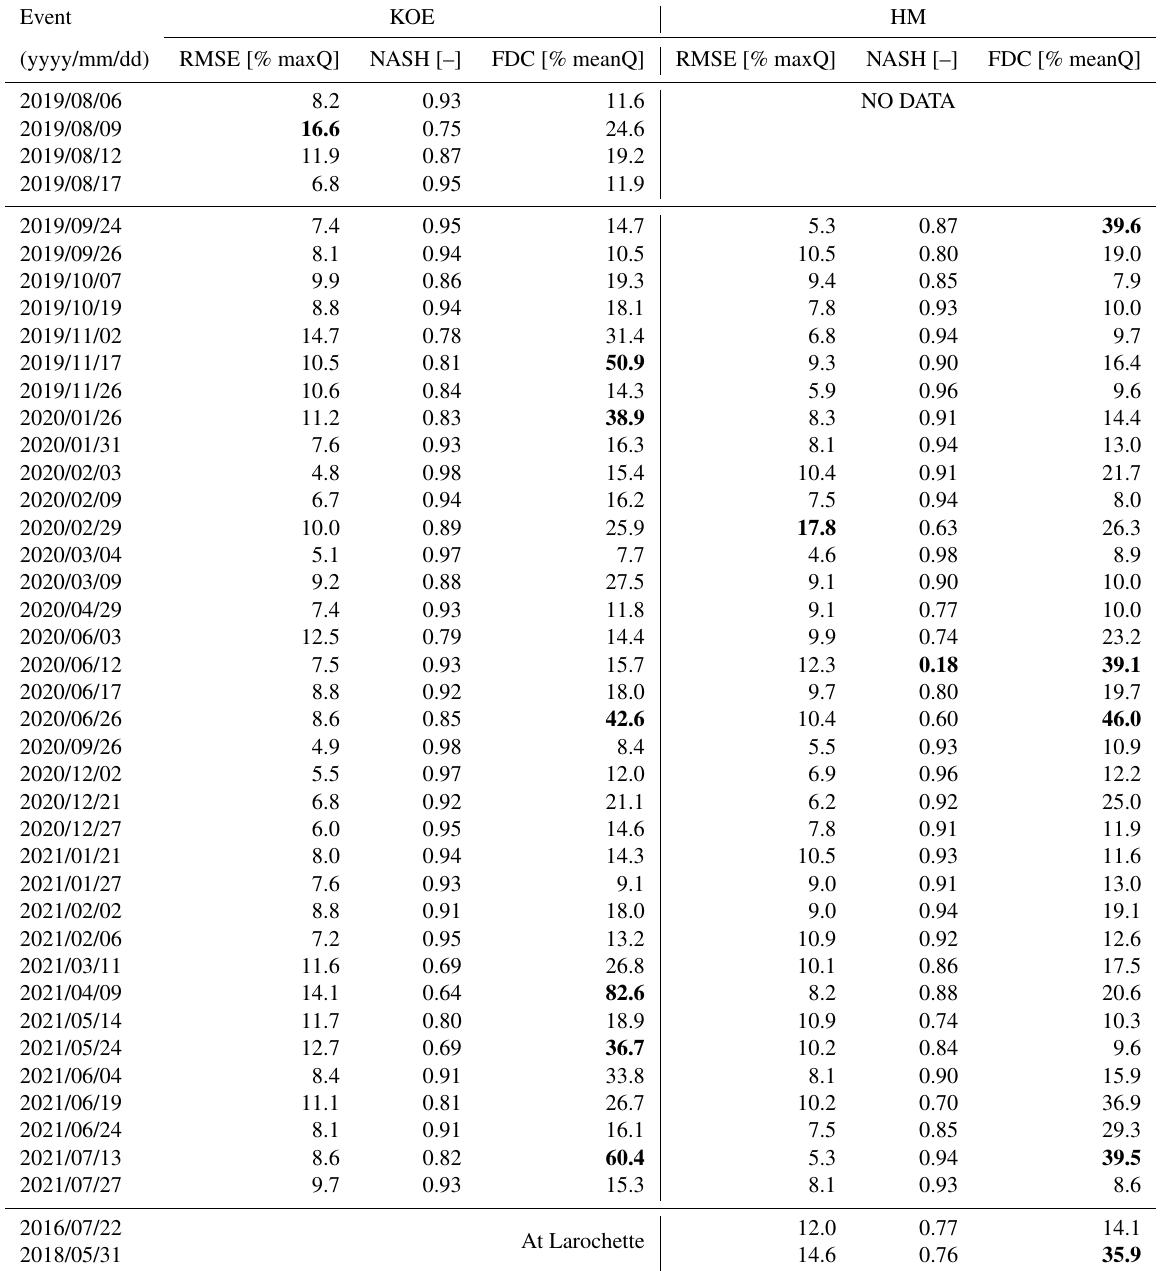
Table 4. Assessment of the models’ calibration. Median score of the likelihood selected simulations: RMSE = root mean square error expressed as a percentage of the observed peak discharge; NASH = Nash–Sutcliffe coefficient; FDC = root mean square error of the flow duration curve expressed as a percentage of the mean discharge. Bad scores are highlighted in